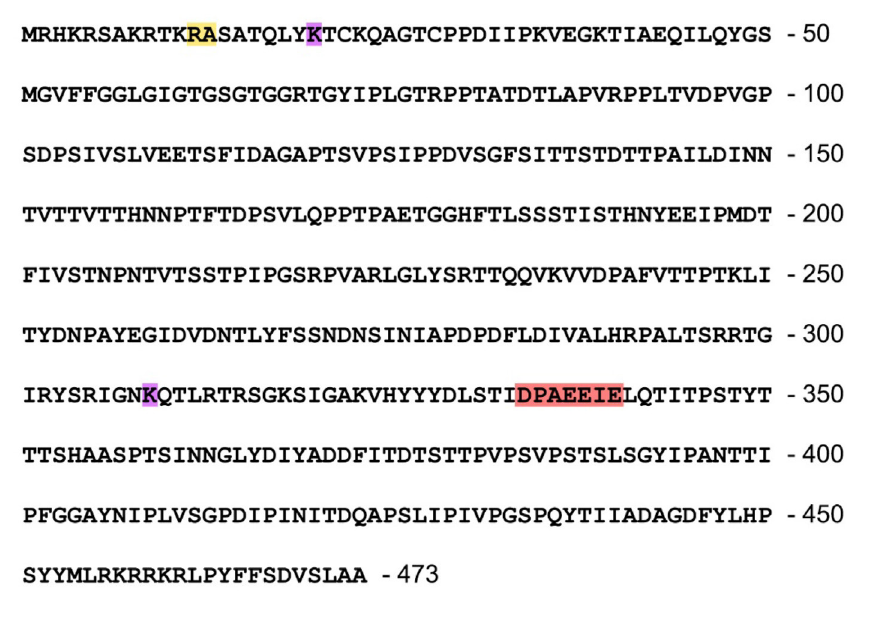
Supplementary Figure 6. HPV16 L2 sequence. The most negatively charged region of the sequence is highlighted in red. The site of furin cleavage (between R12 and A13) (1), which is thought to be transiently exposed on the surface of the virion, is highlighted in yellow. The two lysines (K20 and K309) indicated by our mass spectrometry study to have restricted lysine modification in the presence of HD5 are highlighted in